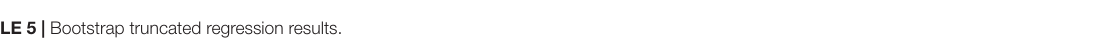
TABLE 5 | Bootstrap truncated regression